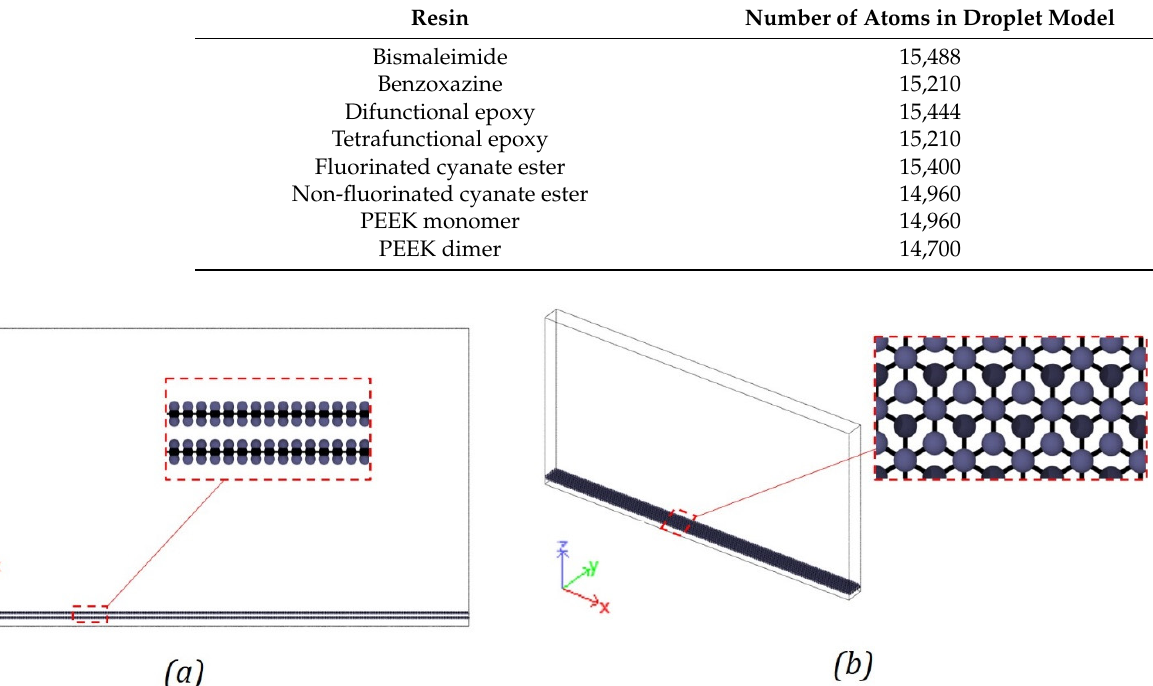
Figure 9. Aromatic carbon surface model with virtual pi electrons ( a ) aromatic carbon surface model with an enlarged view showing Table 1. ( b ) 3D view of the aromatic carbon surface model with an enlarged view in the XY plane.